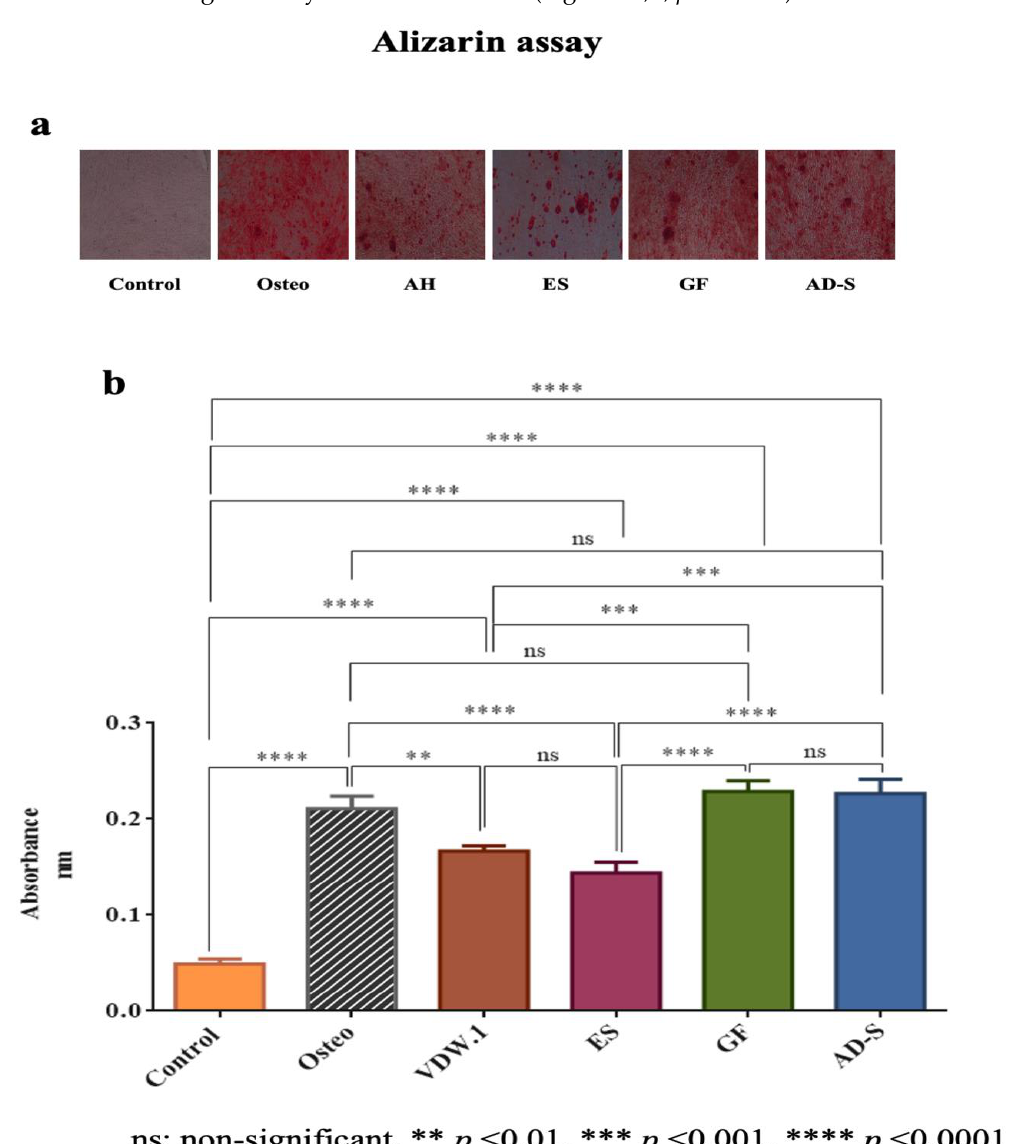
Figure 5. ( a ) Alizarin Red staining for the different sealers (×40 original magnification). ( b ) Bar graph of mean with standard deviation showing the absorbance of Alizarin Red S staining [nm] as an indication of calcium nodules deposition. Osteo—osteogenic differentiation media,